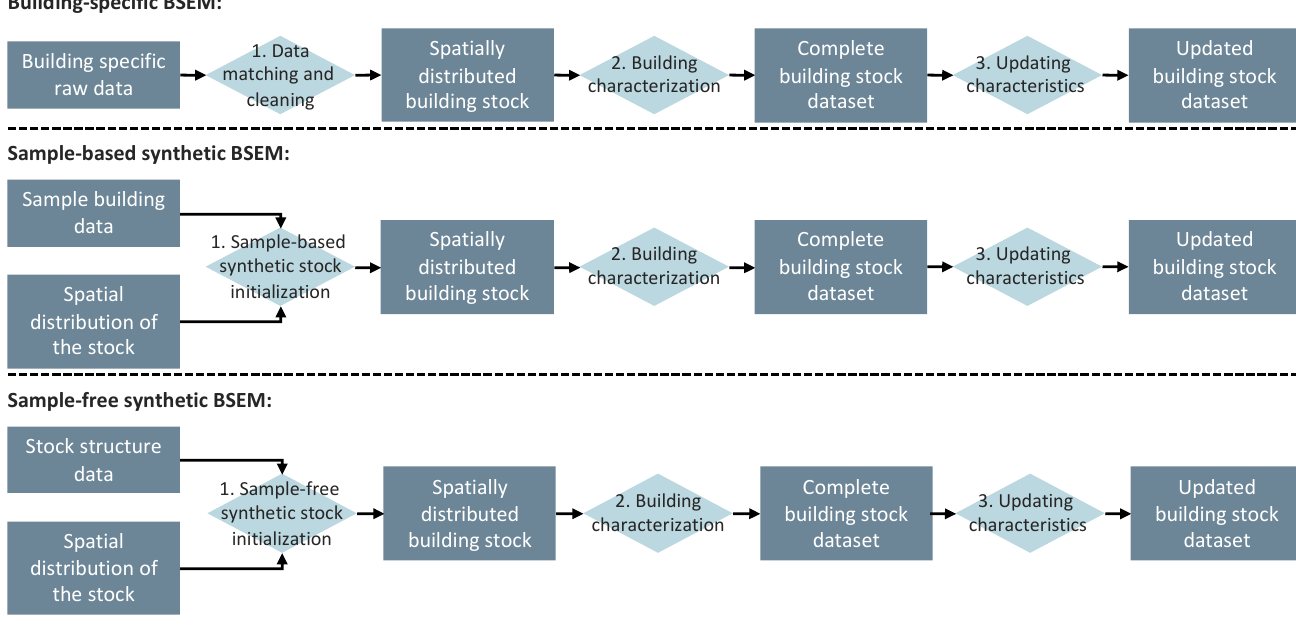
Figure 2. Overview over different approaches for a spatial synthetic building stock dataset generation compared to the common building-specific approach.